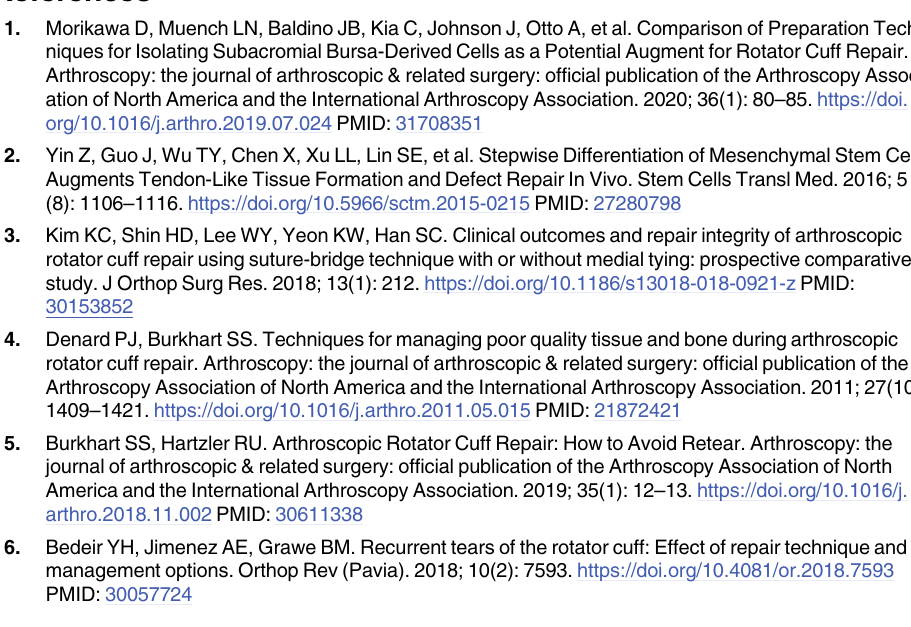
S2 Table. Histological scoring. The three groups were evaluated on four criteria. S3 Table. The relative fibrocartilage formation and percentages of the produced tidemark length relative to the fibrocartilage width at the tendon-to-bone junction. S4 Table. Biomechanical analysis of the application of cell sheets. The maximal load, stiff- ness, and Young’s modulus of the tendon-to-bone